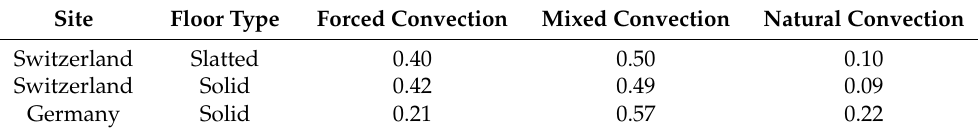
Table 3. Frequency of observed convection regimes for three naturally ventilated dairy